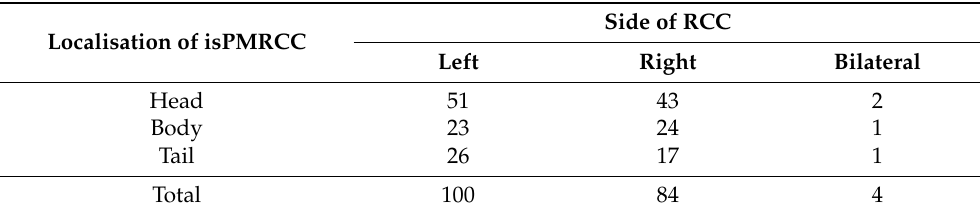
Table 2. Correlation between side of renal cell carcinoma and site of metastasis within the pancreas (N = 188; p =